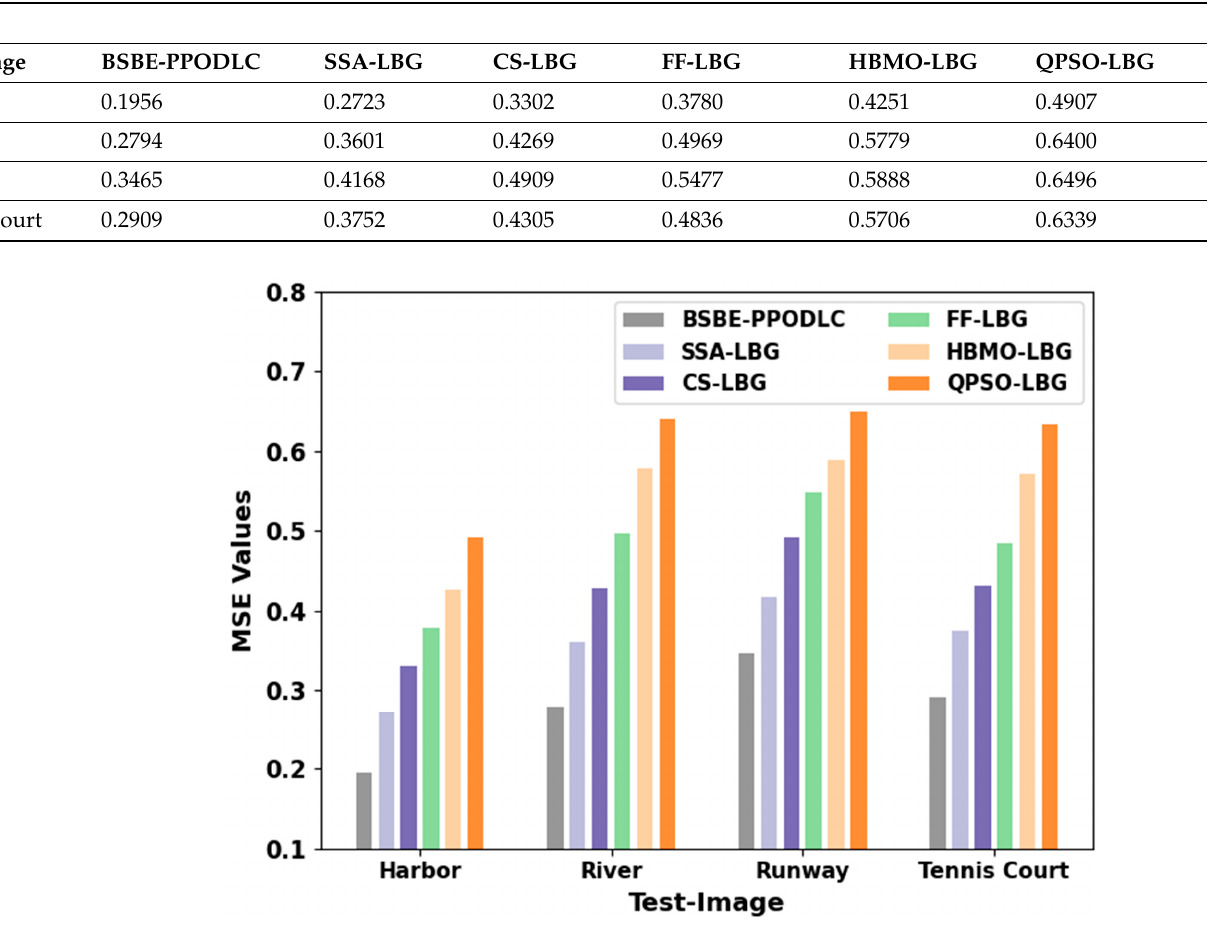
Figure 4. MSE analysis outcomes of the proposed BSBE-PPODLC method for distinct test images.